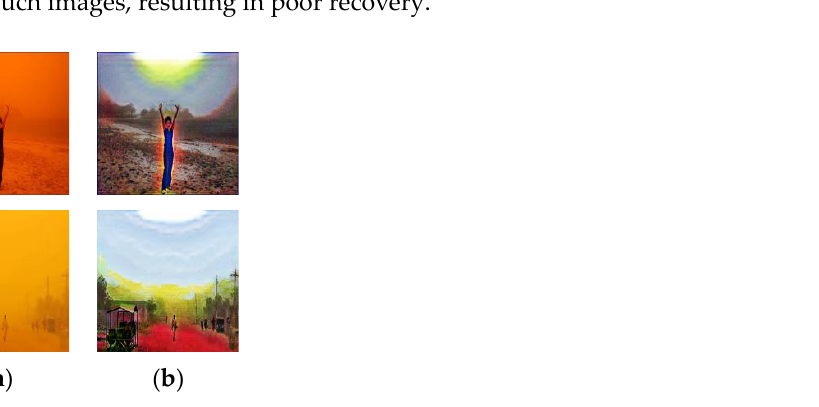
Figure 11. The failure cases; ( a ) Sand-dust images; ( b ) Enhancement results of the proposed method.